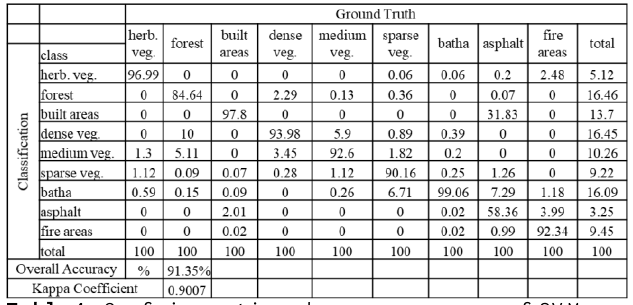
Table 4: Confusion matrix and accuracy measures of SVM multi-temporal classification.